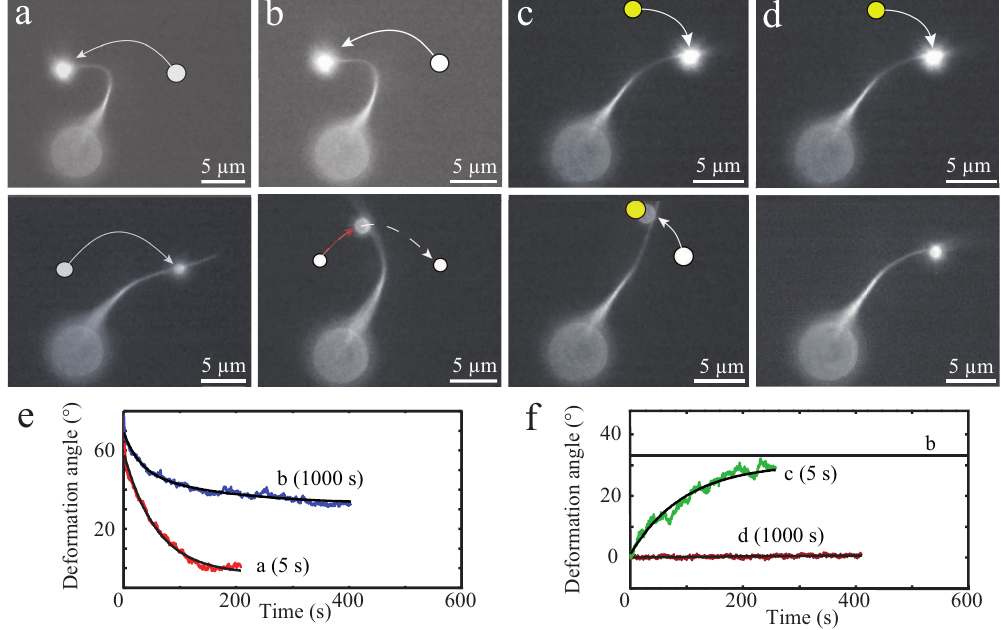
Figure 6. Shown are deformation experiments and according graphs ( e , f ) of an α -actinin crosslinked actin bundle and its time dependent responses to external deformations. ( a ) the bundle was deformed on a short time scale by moving the trapped bead along a predefined arc with a subsequent holding time of 5 s in the deformed configuration. For short deformations, a crosslinked bundle restored its original configuration after stress release; ( b ) deformations on a long time scale with a deformation time of 1000 s lead to dynamic rearrangements of crosslinkers causing a plastic deformation. The bundle relaxed only partially to a new equilibrium position; ( c ) the bundle was deformed to its former zero position with a holding time of 5 s. After stress release, the bundle returned to its new equilibrium position; and ( d ) this procedure was repeated with a deformation time of 1000 s, which restored the initial equilibrium position of the bundle by dynamic crosslinker rearrangements. Thus, the effect